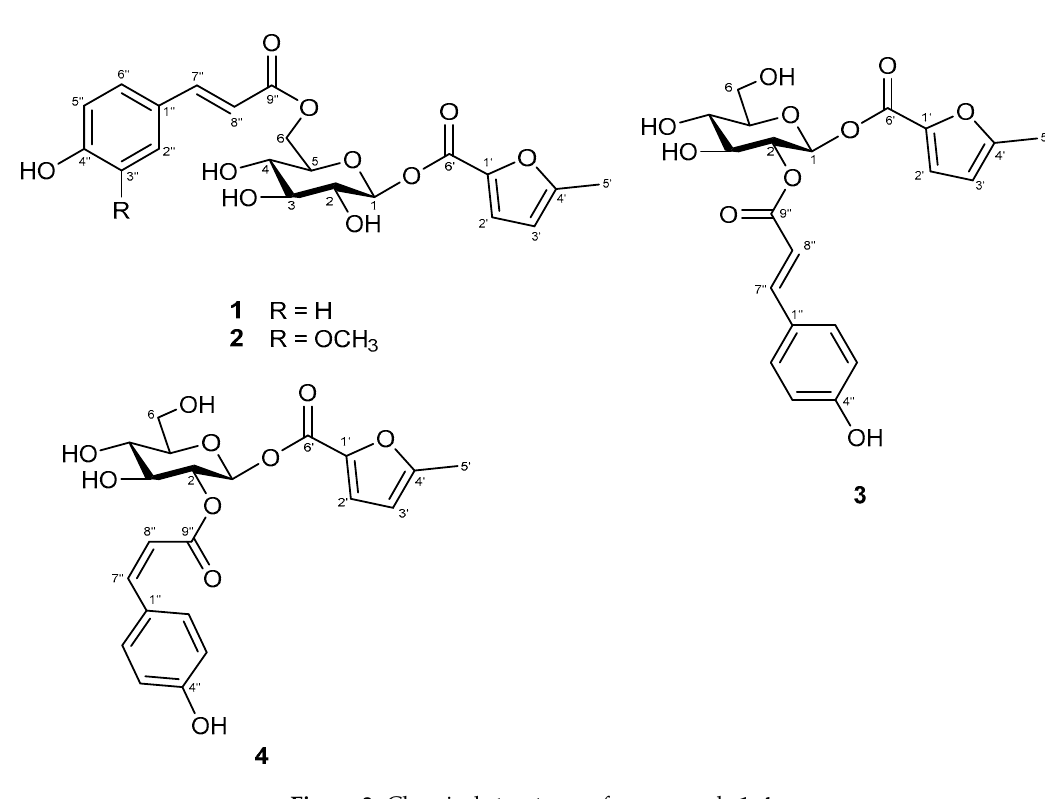
Figure 3. Chemical structures of compounds 1 – 4 .